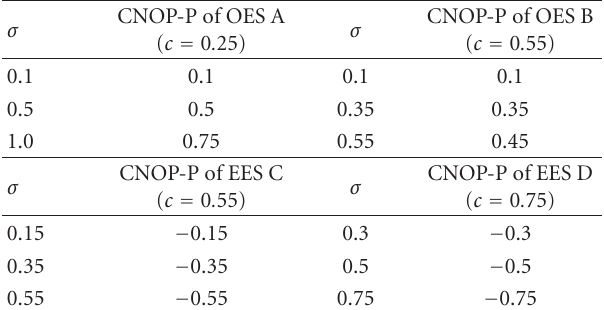
Table 2: CNOP-Ps corresponding to di ff erent basic